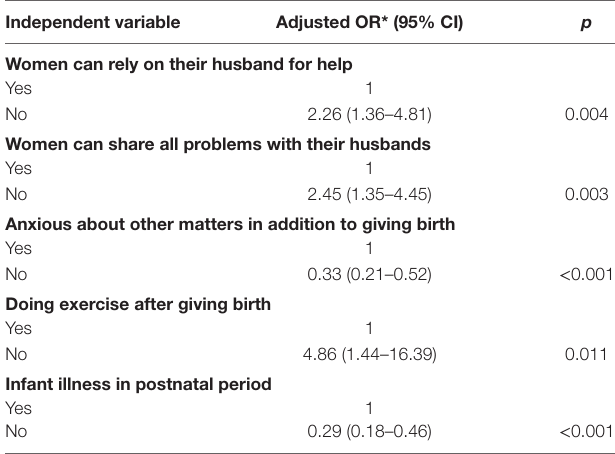
Table 2 | Factors associated with postpartum depressive symptoms ( N =